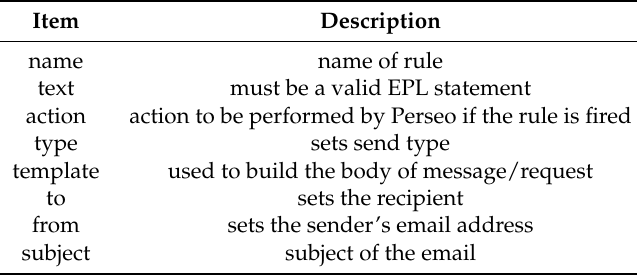
Table 3. Details of the Perseo